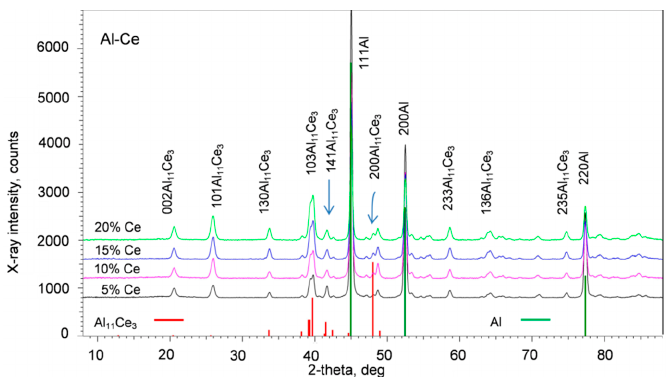
and Al 11 Ce 3 PDF